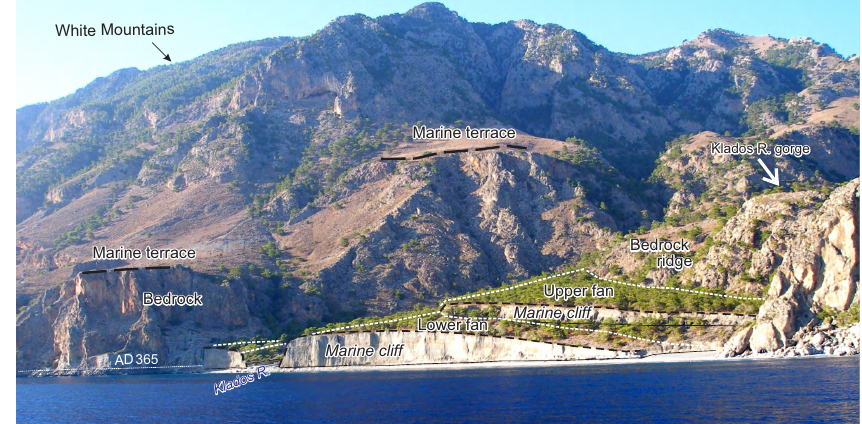
Figure 2. Northward view of the beach at Domata illustrating the two generations of fan surfaces and their separate episodes of marine trimming. The location of the Klados Gorge, the two elevated marine benches cut on bedrock and the AD365 uplifted shoreline are indicated (for a close-up view of the bioerosional AD365 notch see Fig. 6c).